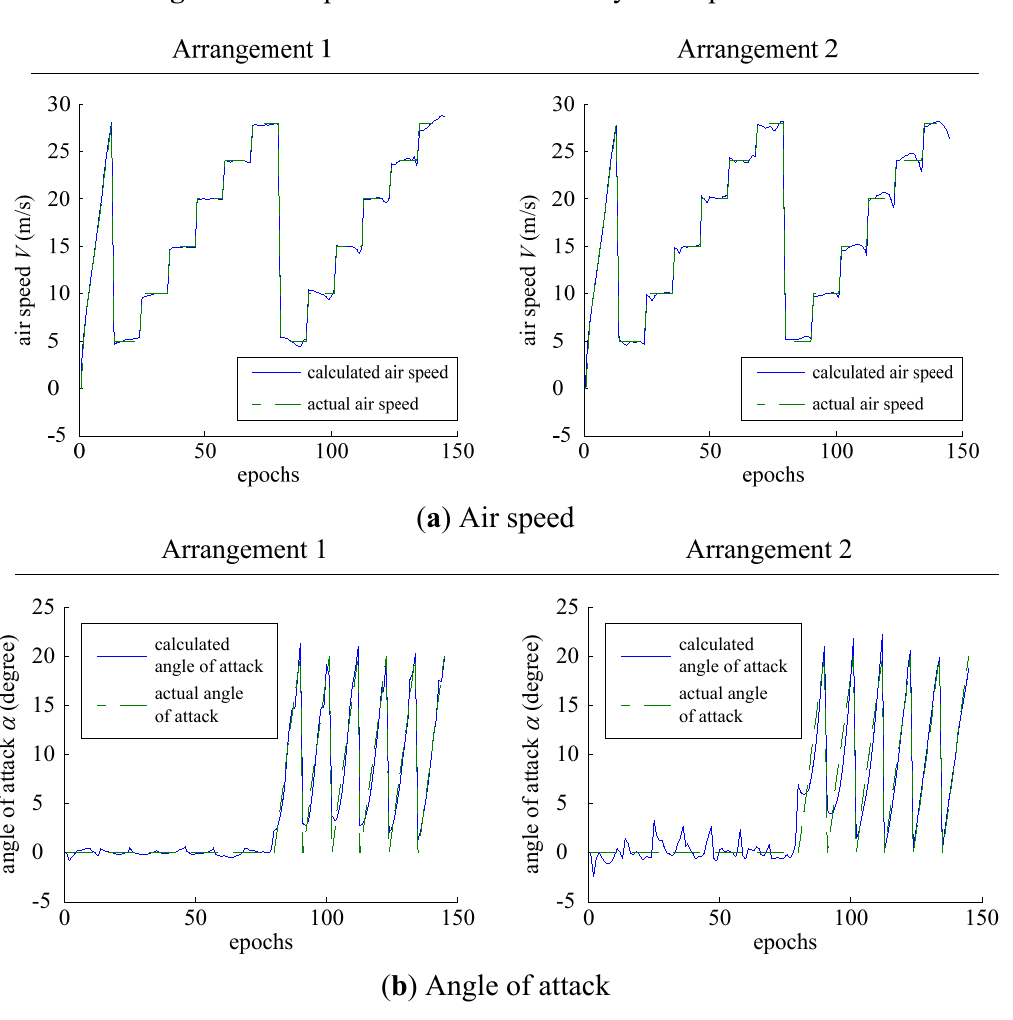
Figure 9. Comparative results of aerodynamic